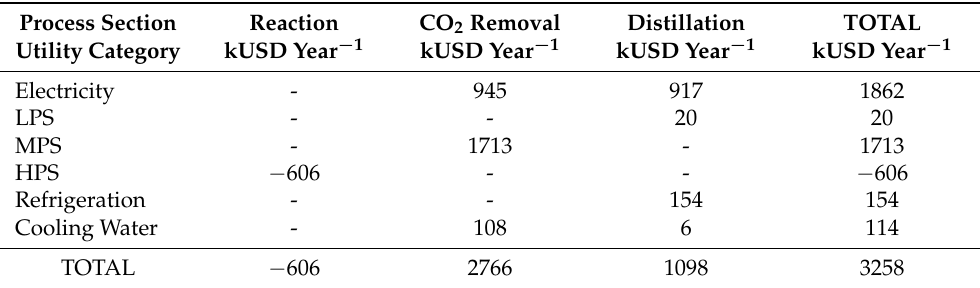
Table 4. Yearly cost rates for the different utility in each process section. Positive values mean consumption, while negative values mean export.